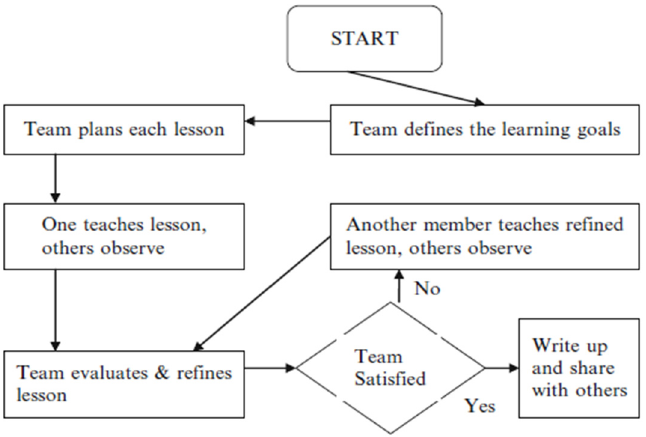
Figure 5. LS cycle [30] (p. 568).